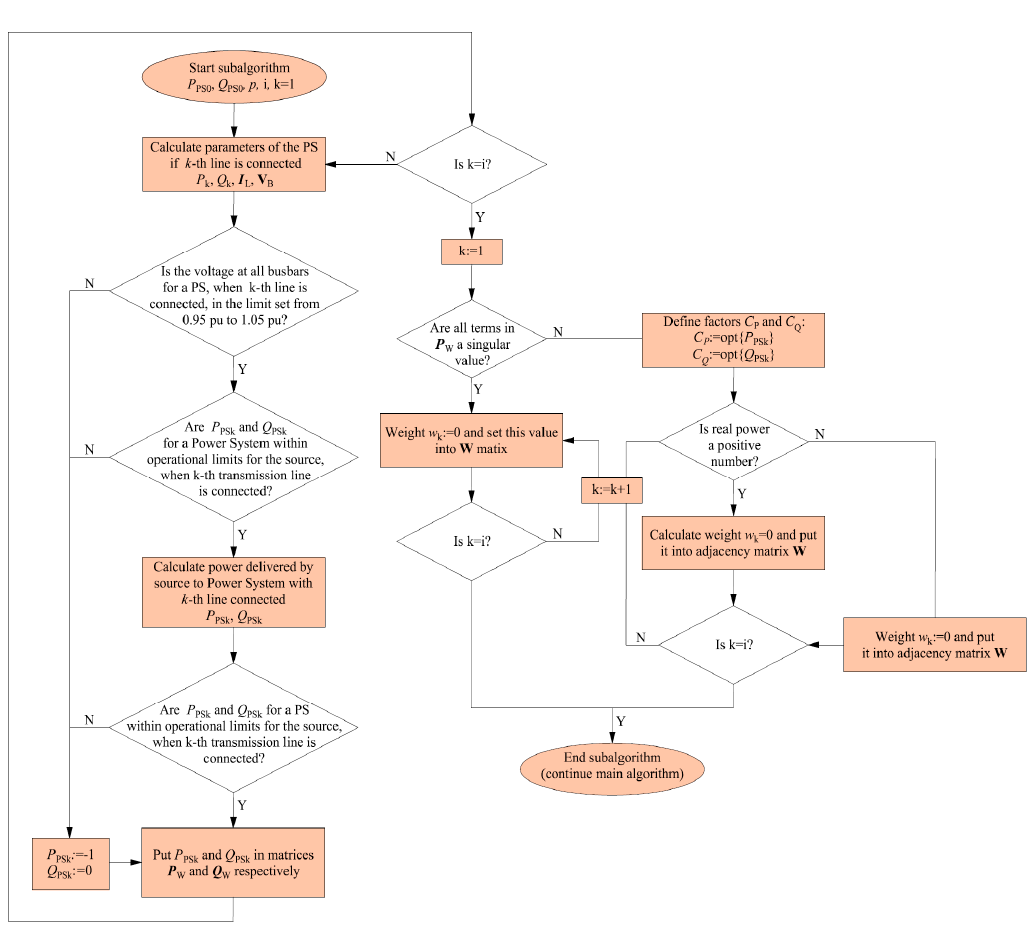
Figure 3. Weight calculation algorithm for strategy combining influence of real and reactive power.